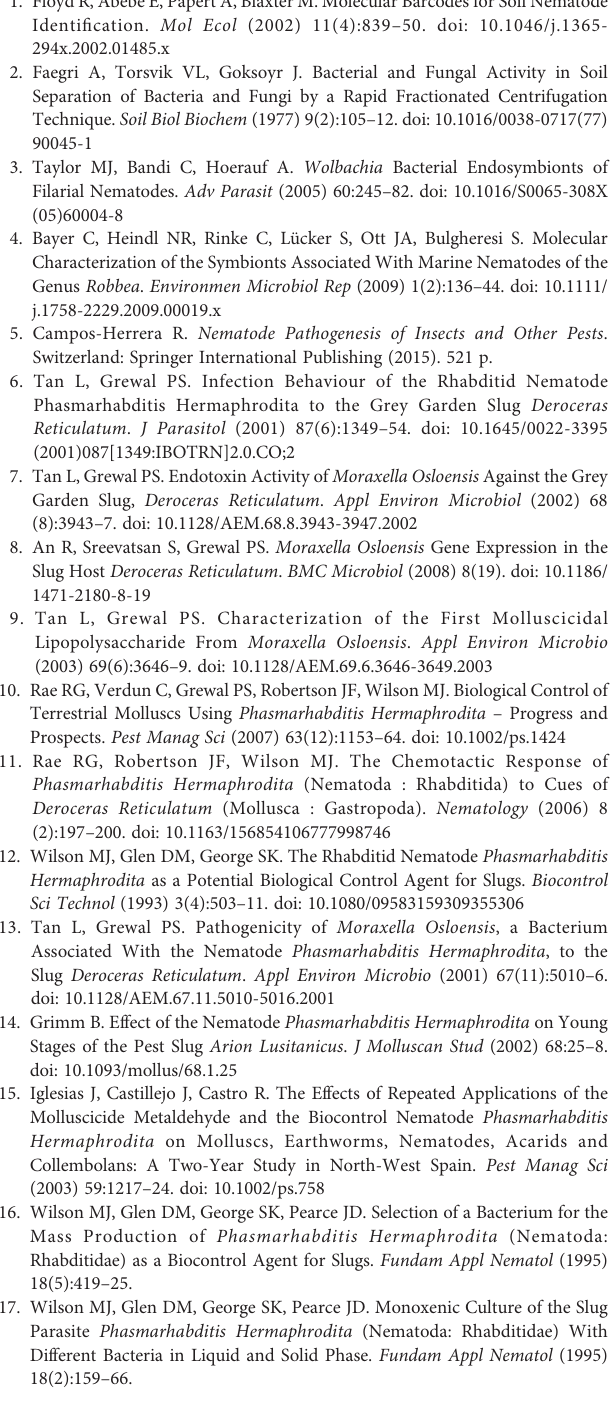
Supplementary Figure 1 | Beta diversity comparison for each sample was completed via a Principal Component Analysis (PCA). PCA demonstrates that C.DMG0001 samples are very similar toeach other with alower overall diversity, yet all sample which killed a slug show a greater diversity of bacteria.